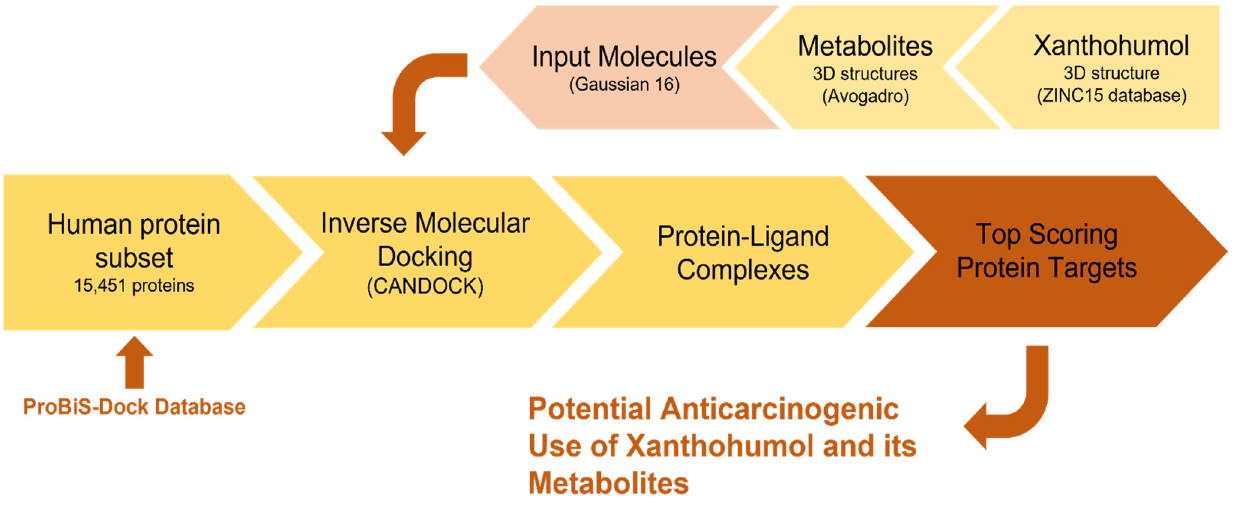
Figure 2. The workflow of the protein target prediction approach. Using inverse molecular docking, xanthohumol was docked into target human proteins from the Protein Data Bank (PDB) with pre- dicted binding sites from the ProBiS-Dock database. Inverse molecular docking was performed with the CANDOCK algorithm.